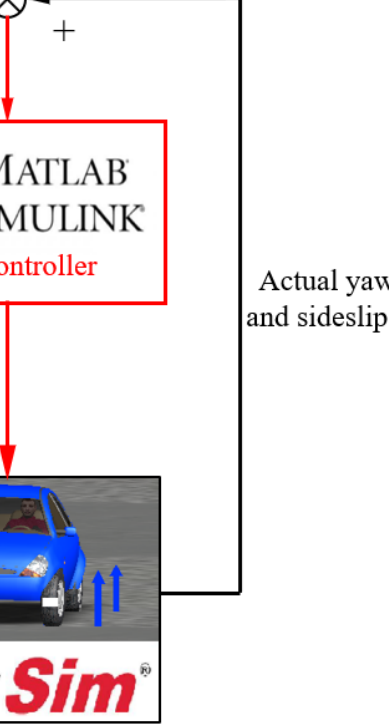
Figure 3. Electronic stability program (ESP) controller model. According to the monorail model with two degrees of freedom, the ideal values of yaw rate and mass sideslip angle of the ESP control system are generated, and the difference is calculated with the actual measured yaw rate and the center of the mass sideslip angle. PID control is carried out to output the difference of the left and right wheel moments.